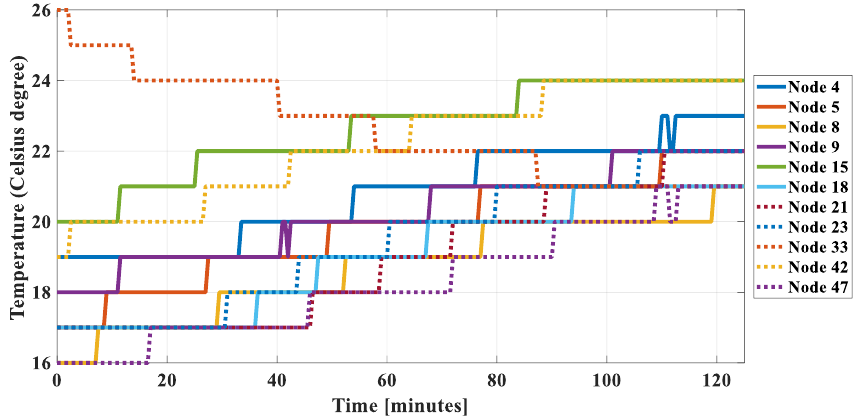
Figure 5. Temperature data measured at 11 nodes in the dataset 1.